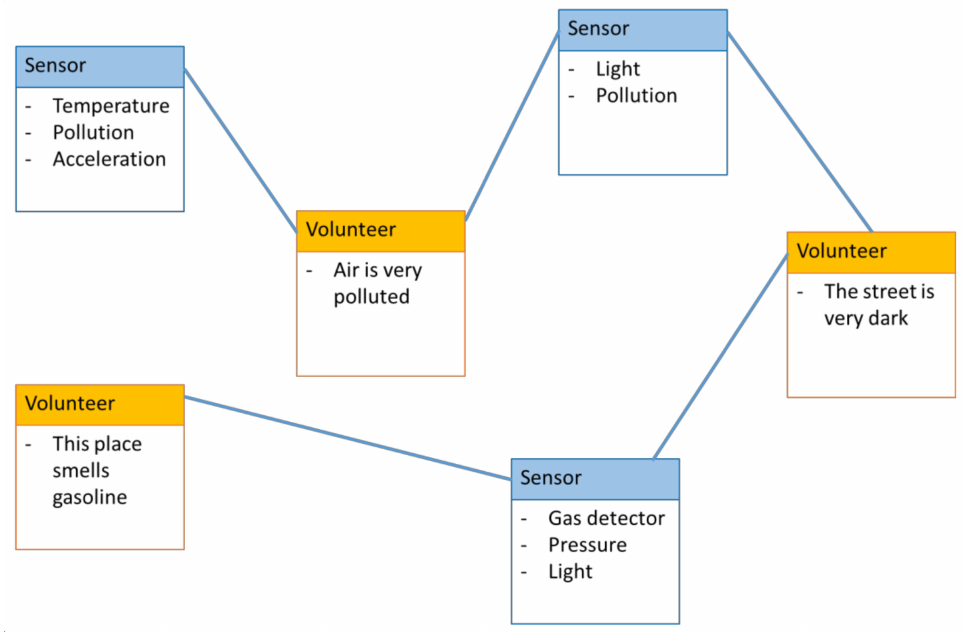
Figure 4. Relationships of sensor and volunteers based on observed